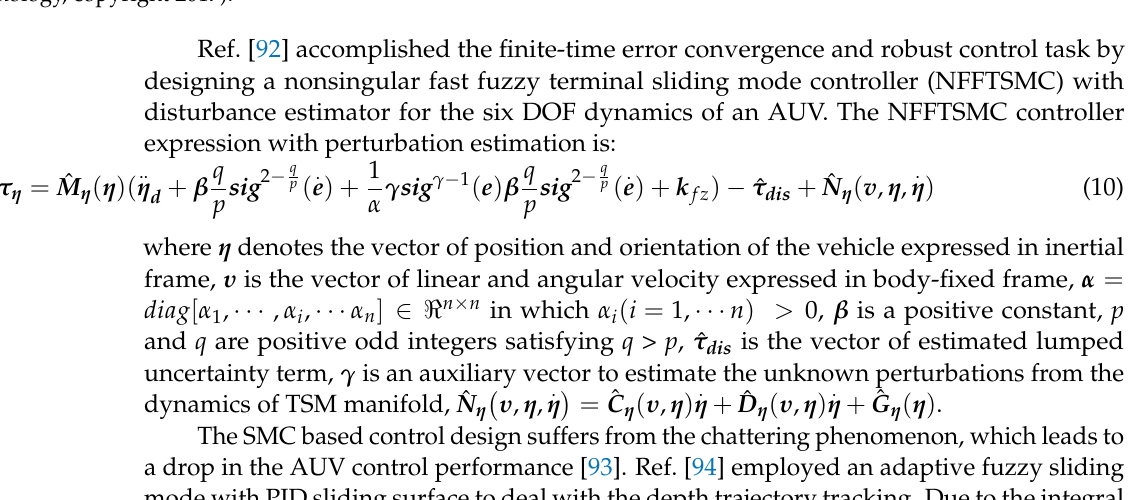
Figure 5. ANITSMC control block diagram (Reprinted from reference [91] with permission from the Institution of Engineer- ing and Technology, copyright